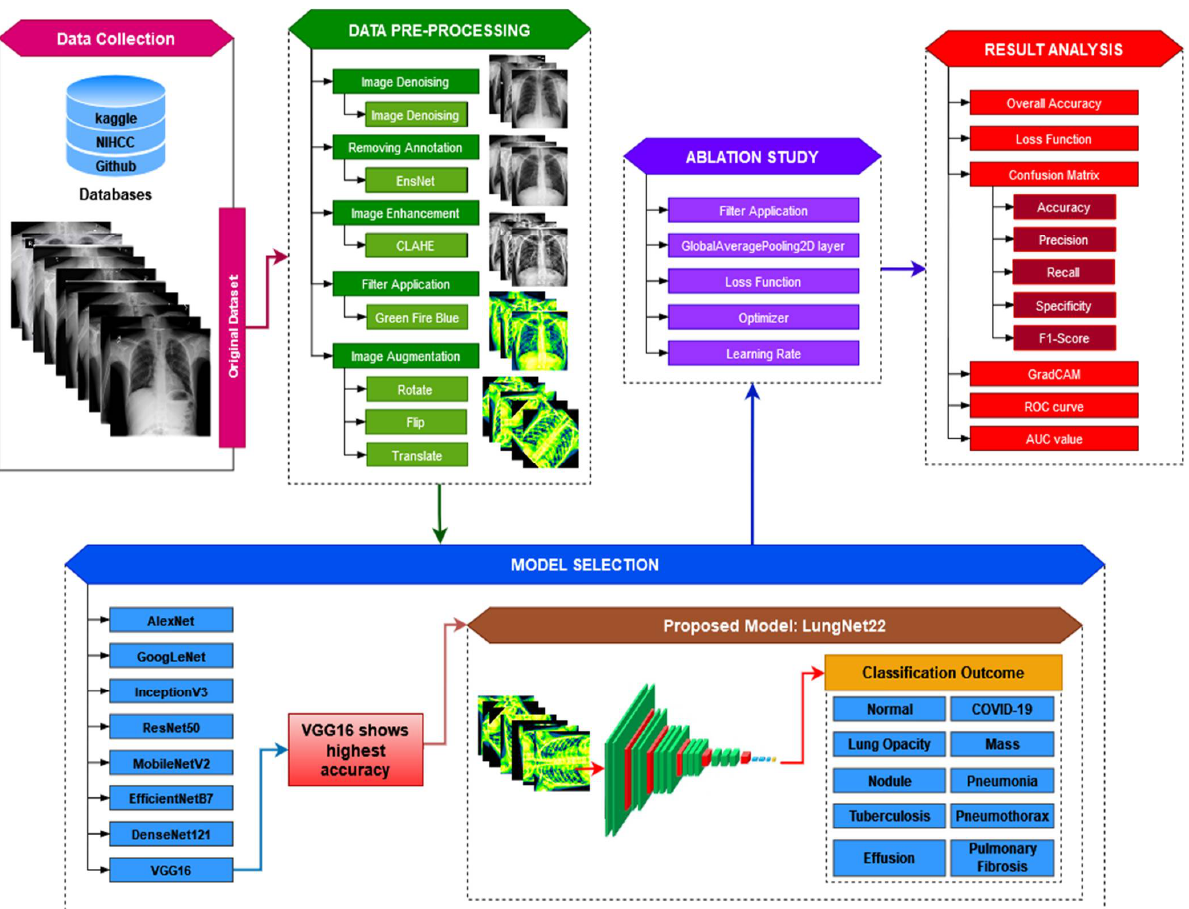
Figure 1. Operation of the proposed LungNet22 model for multiclass classification of lung disease.